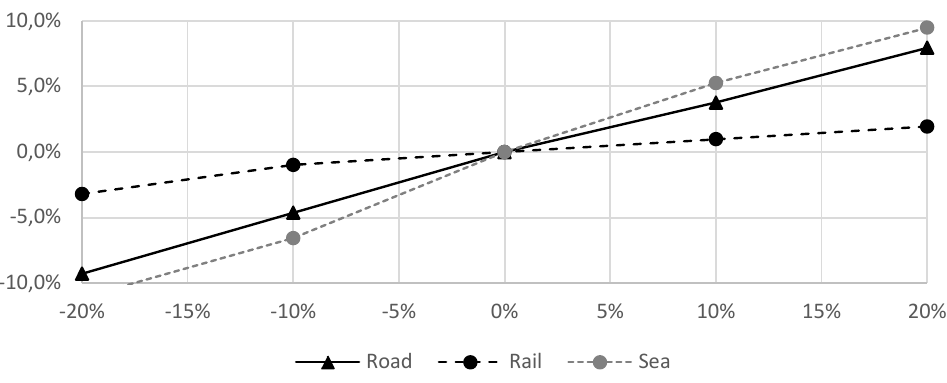
Figure 3. Change in average consolidation levels per mode in, to and from Sweden as a function of change in total transport